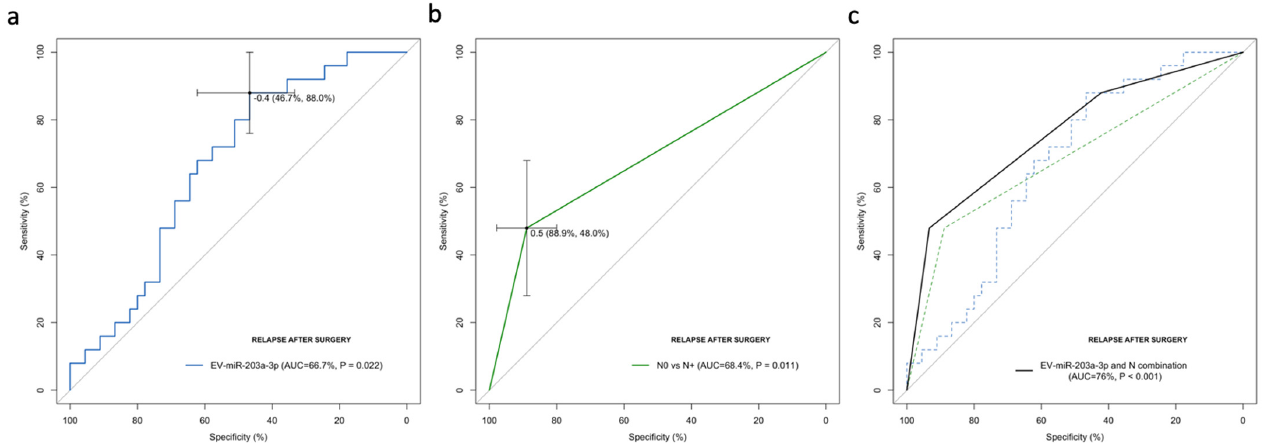
Figure 7. ROC curve analysis for the prediction of post-surgical relapse in NSCLC patients accord- ing to ( a ) TDV EV-miR-203a-3p, ( b ) N status and ( c ) the combination of TDV EV-miR-203a-3p (high vs. low) and N (N0 vs. N+).